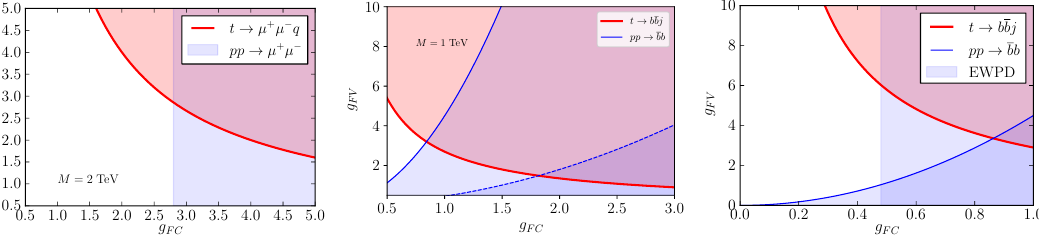
Figure 4 . Parameter space region that can be bounded by rare top decays in the HL-LHC (red) versus the one that could be excluded using other searches (blue) neglecting systematic uncertain- ties. In the left panel we consider a scalar leptoquark extension of the SM, in the center and the right panels we consider two versions of a Z 0 model; see text for